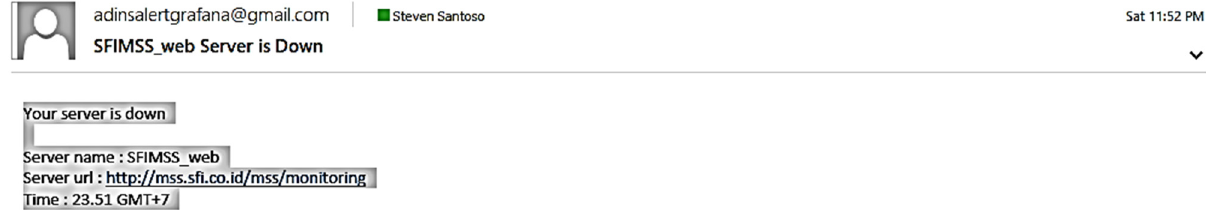
Figure 7: Alert server down